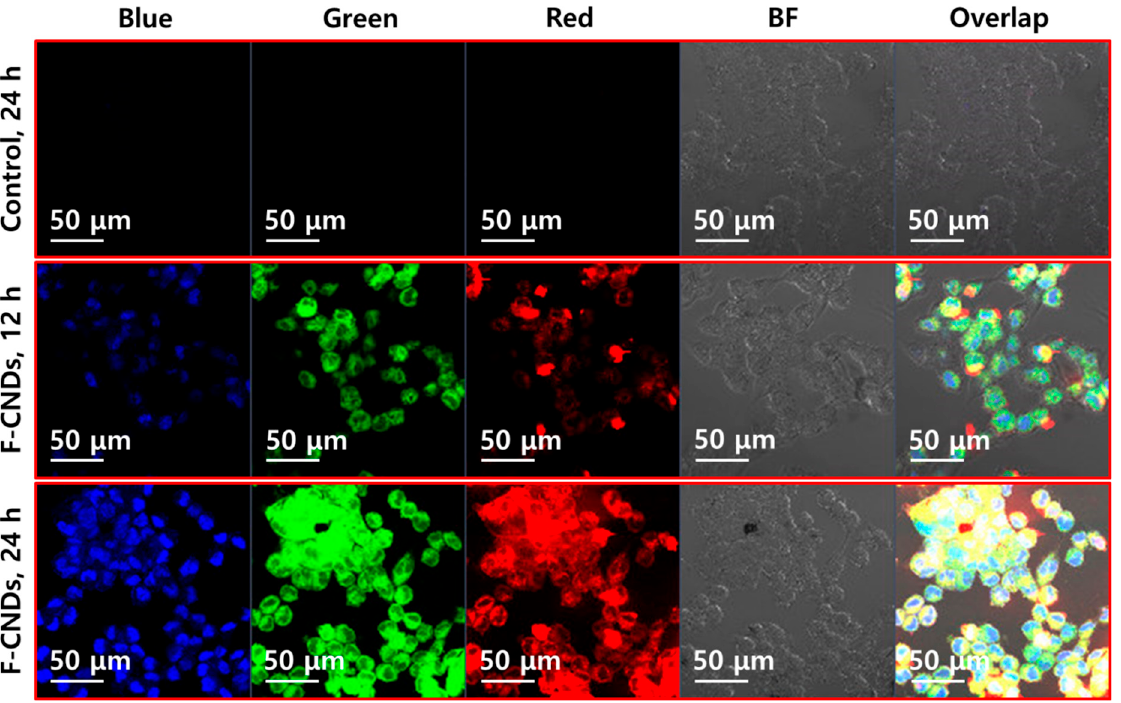
Figure 6. Confocal microscopy fluorescence images of human colon cancer cells treated with or without F-CNDs and the synthesized F-CNDs treated for 12 and 24 h with the concentration of 100 μ g mL − 1 using different excitation filters 405, 488, and 555 nm (blue, green, and red, respectively) as well as bright-field illumination.